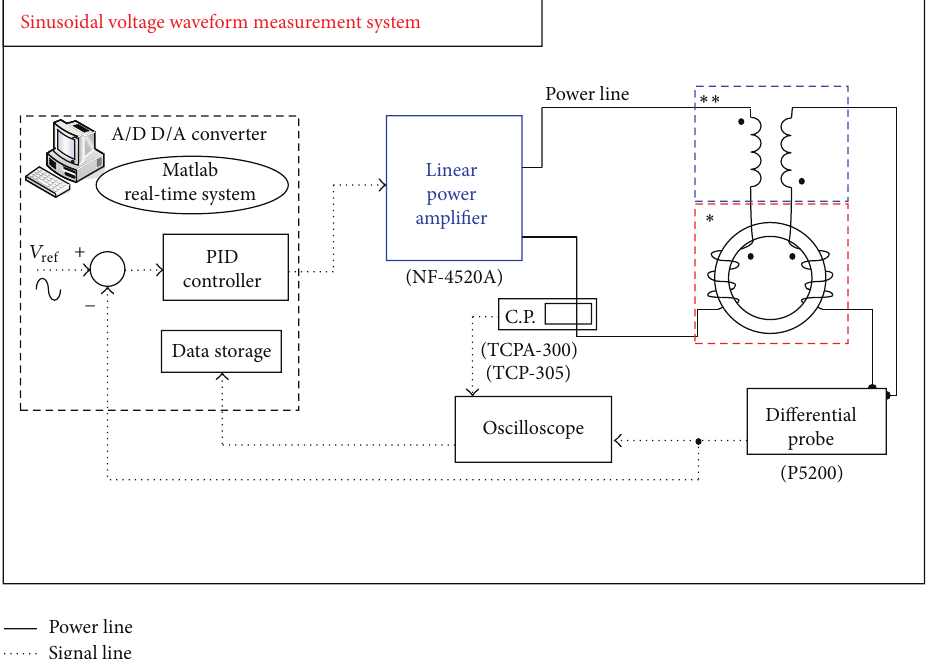
Figure 9: Measurement system under sinusoidal voltage waveform. ∗ Standardized toroidal frame with high repeatability, ∗∗ air-flux compensator windings.